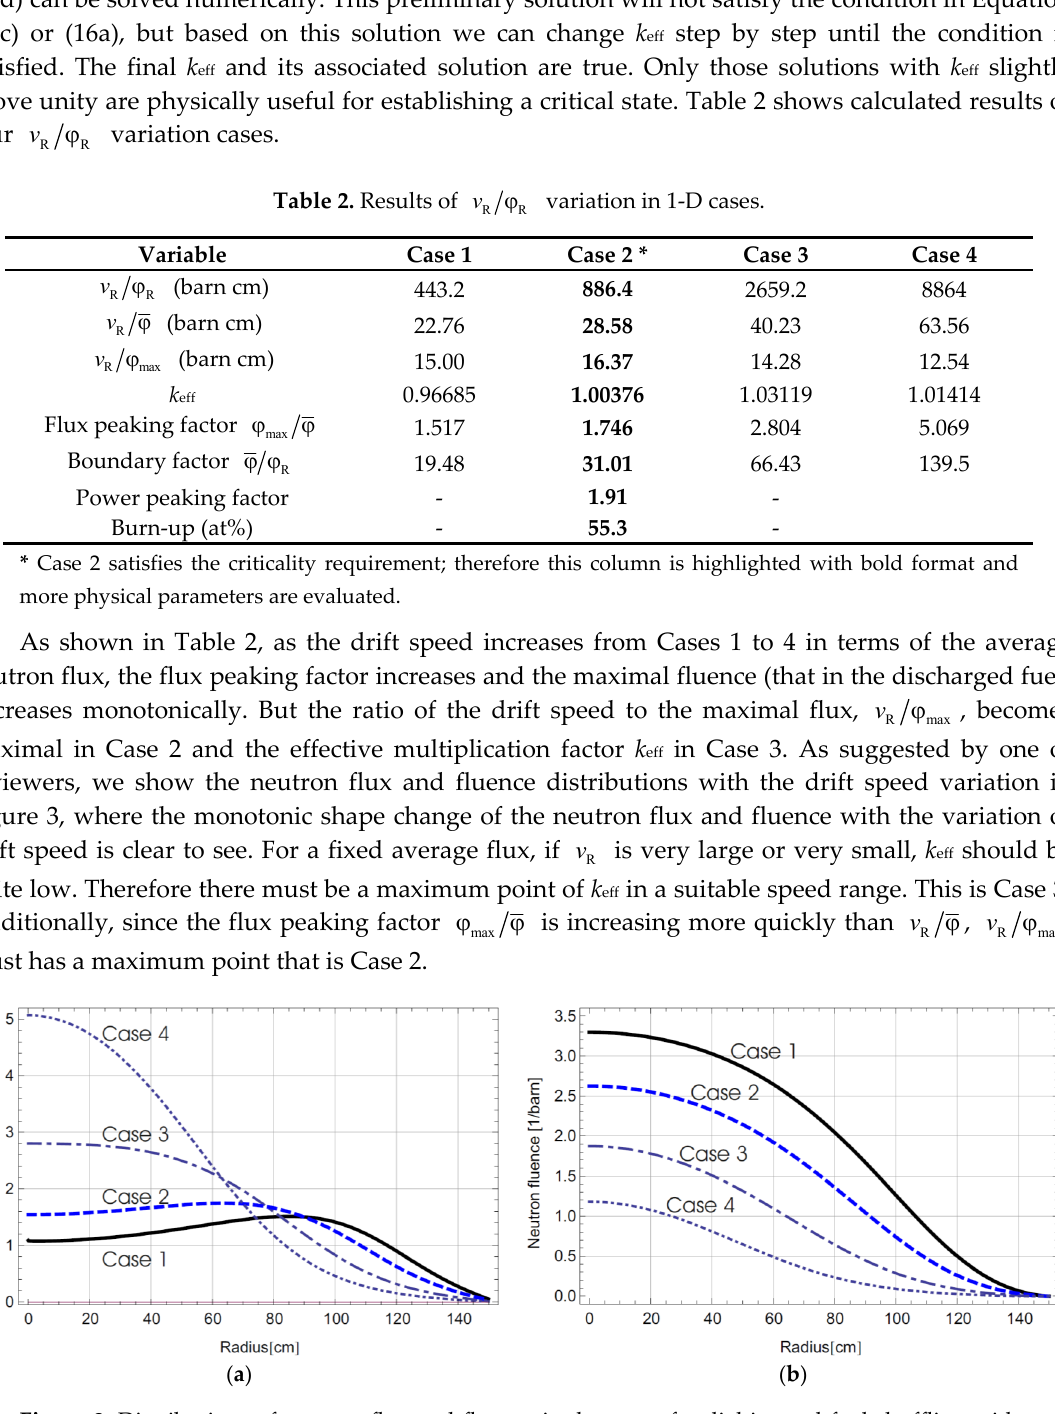
Figure 3. Distributions of neutron flux and fluence in the case of radial inward fuel shuffling with v  variation in Table R R